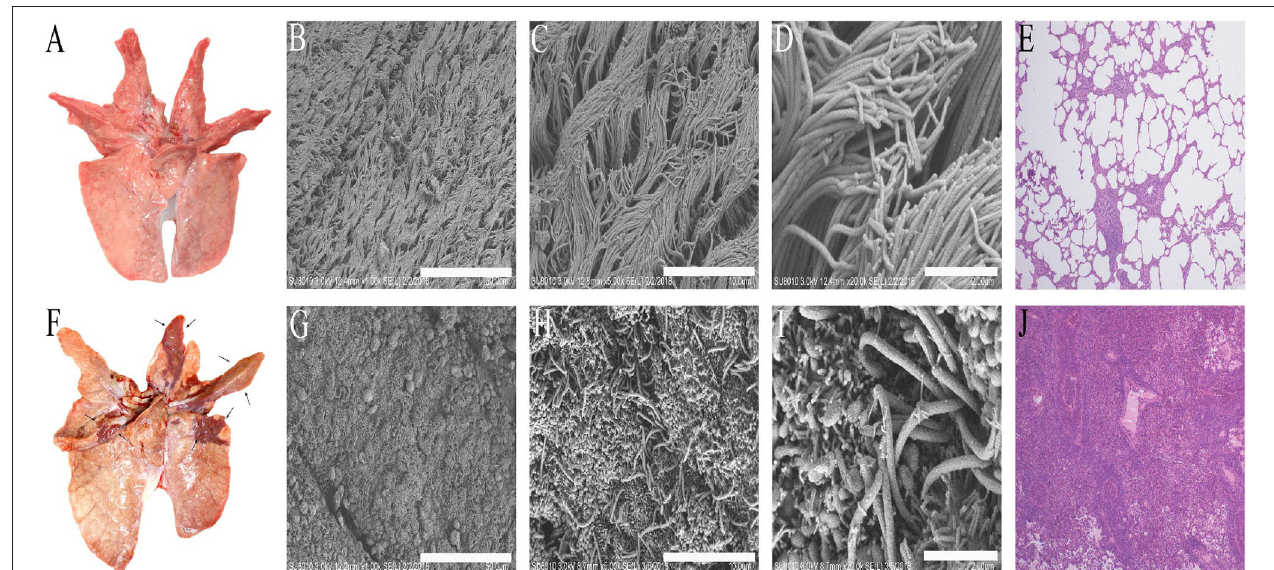
FIGURE 4 | The typical lesions caused by M. hyopneumoniae occurred in the lungs of pigs infected with strain ES-2. The lung tissues were observed on day 38 after infection. (A) The lung tissues of pigs inoculated with modified Friis liquid medium served as blank group. (B) (Bars 2 µ m). The tracheal surface (ciliated epithelial cells and microvilli) was observed by scanning electron microscope. (E) (40 is shown. (F) Typical macroscopic lesions caused by M. hyopneumoniae were observed in the lungs of pigs infected with 7 ES-2. (G) (Bars 50 µ m), (H) (Bars 10 µ m), and (I) (Bars 2 µ m). The tracheal surfaces of the lungs of pigs infected with strain ES-2 (almost all the fluff is loss) = = = were observed by scanning electron microscope. (J) (40 ) The hyperplasia of peribronchiolar accumulation of mononuclear cells and the epithelial cells was observed × from the lungs of pigs infected with ES-2 by HE